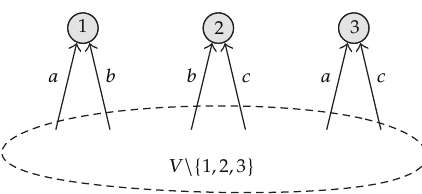
Figure 4: Example of fractional label